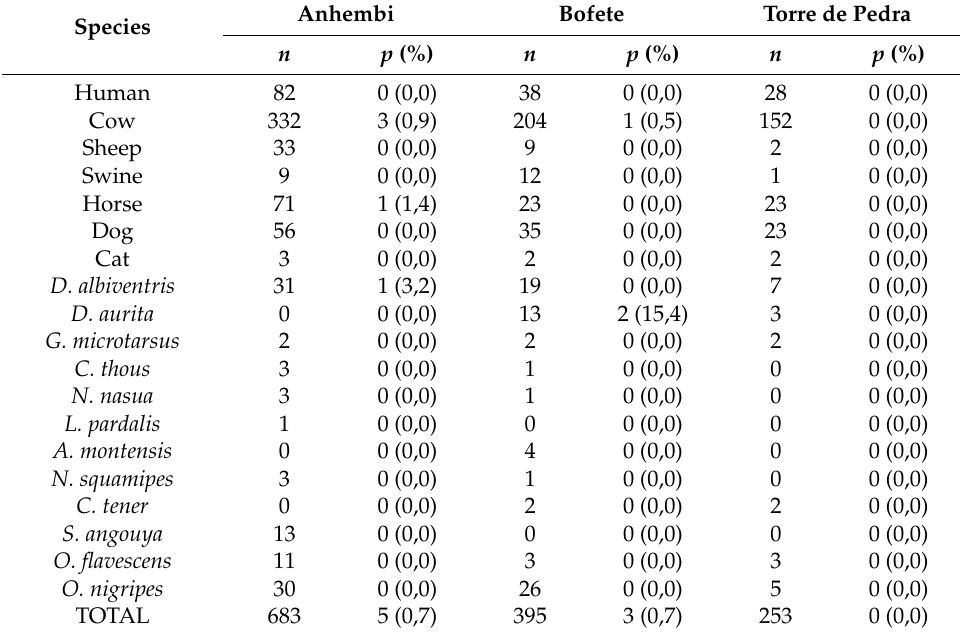
Table 2. Blood samples distribution among municipalities and proportion of PCR positives between different species.